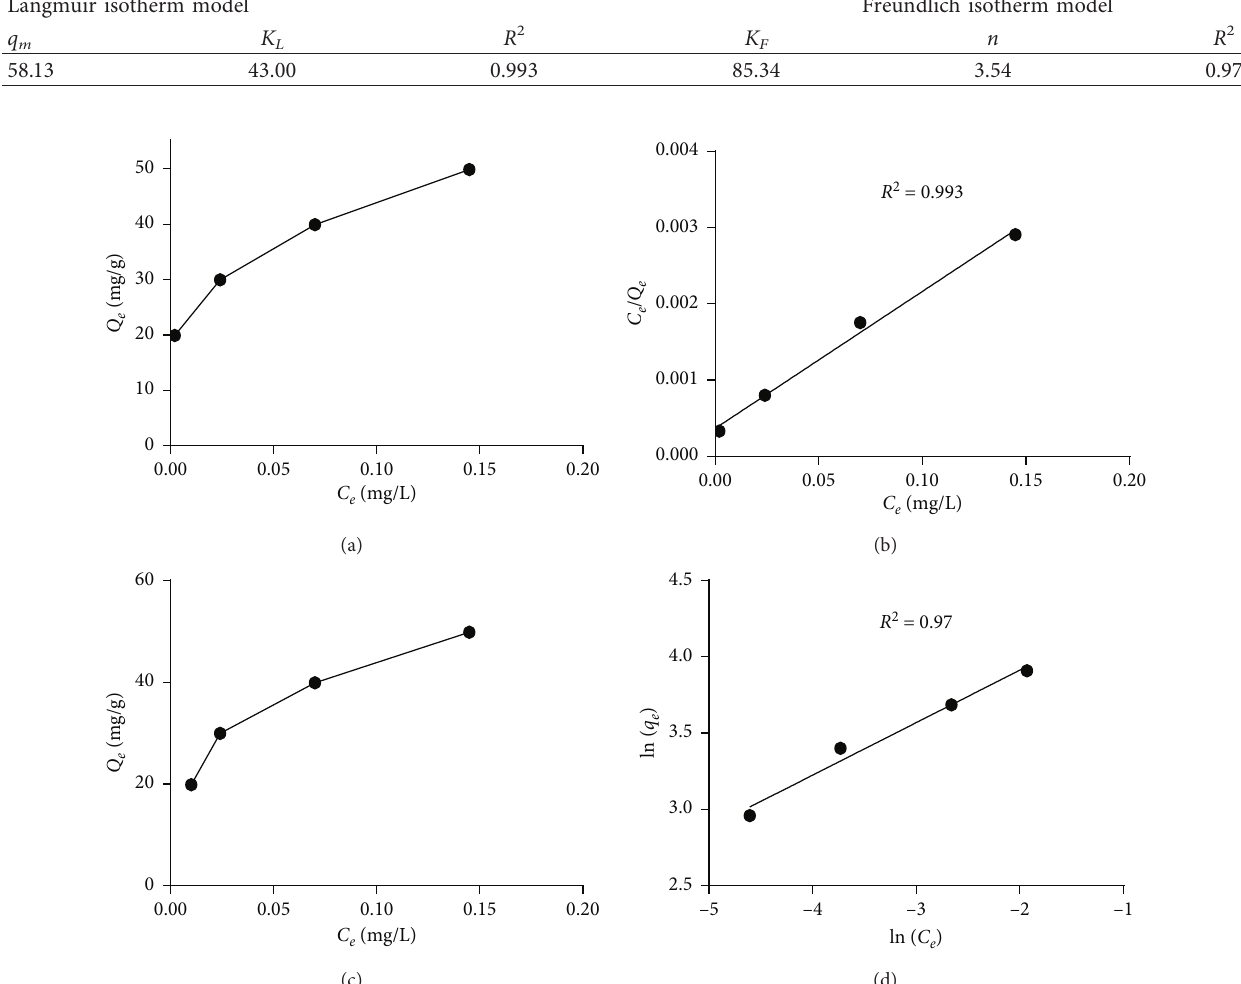
Figure 10: Isotherm model for BG dye adsorption: (a) and (b) Langmuir isotherm model; (c) and (d) Freundlich isotherm